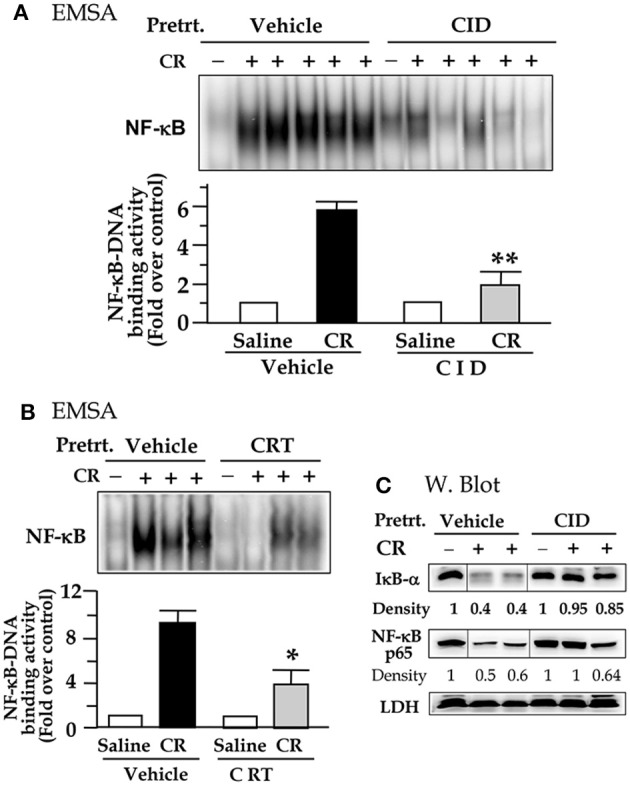
PKD inhibitor CID755673 or CRT 0066101 pretreatment attenuates NF-κB activation in cerulein-induce experimental pancreatitis. Rats received intraperitoneal (IP) injection of CID755673 (CID, 15 mg/kg) or CRT 0066101 (CRT, 10 mg/kg) or same volume of vehicle. After 60 min waiting time, the inhibitor- or vehicle-pretreated animals were given an IP injection of cerulean (CR) or saline (S). The pancreas was collected in 30 min after the cerulein or saline injection. (A,B) NF-κB binding activity was measured in pancreatic tissue nuclear extracts by EMSA. Each lane represents one rat. **p < 0.01 or *p < 0.05 vs. cerulein alone without inhibitor pre-treatments. (C) IκB-α degradation and nuclear translocation of NF-κB were measured in pancreatic tissue cytosolic extract by Western blot. LDH: for cytosolic extract loading control. Samples were run in a single gel but were not continuous, as indicated by a line between lanes.